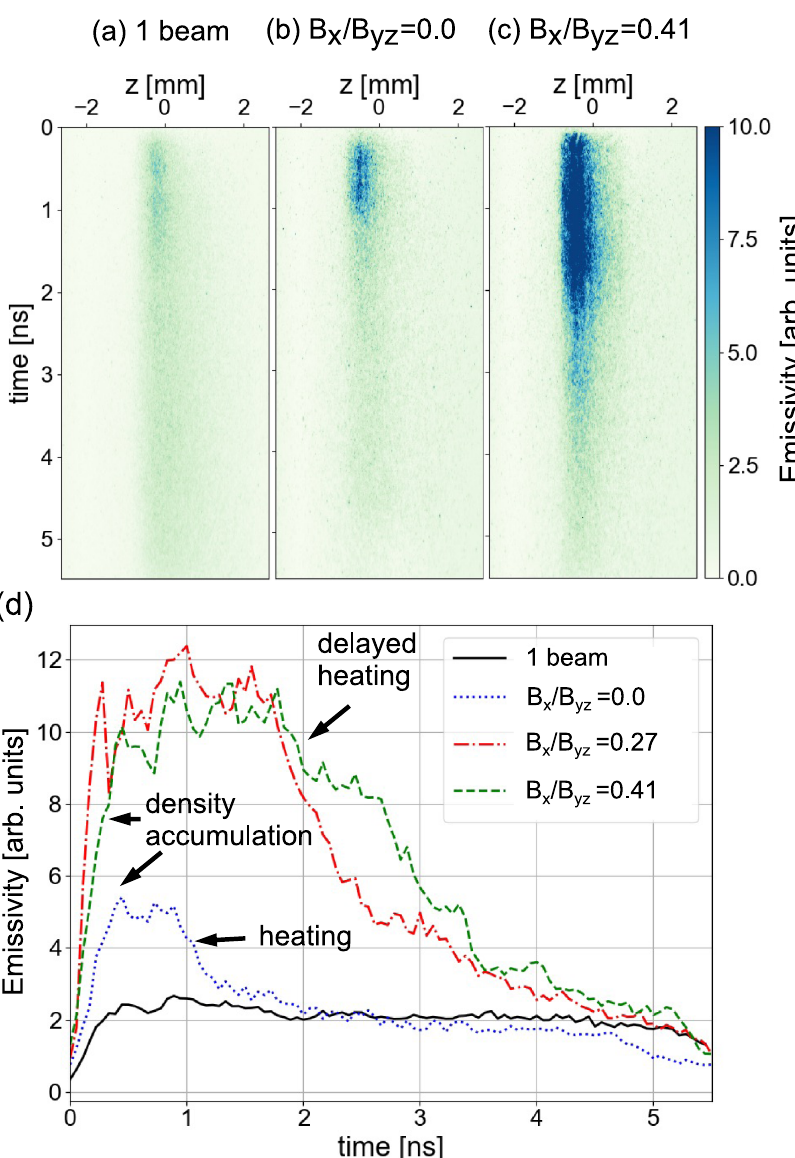
Fig. 2 | Laboratory optical pyrometry observation of delayed heating in the reconnection area and in the presence of a guide fi eld. a – c streaked images of the self-emission of the plasma in the reconnection region as recorded in the laboratory experiment along the z -axis (see Fig. 1), in the mid-plane between the irradiation spots of the L2 and L3 lasers. The self-emission is recorded for photons around(470±135)nmwavelengthandintegratedover230 μ malongthe y -axis(see Fig. 1). Panel a corresponds to only one laser beam (L2) turned on. Panels b and c correspondtothecasewhereL2andL3are fi red;forpanel b oncoplanartargets, while for panel c the targets are tilted, resulting in the presence of a B x / B yz =0.41